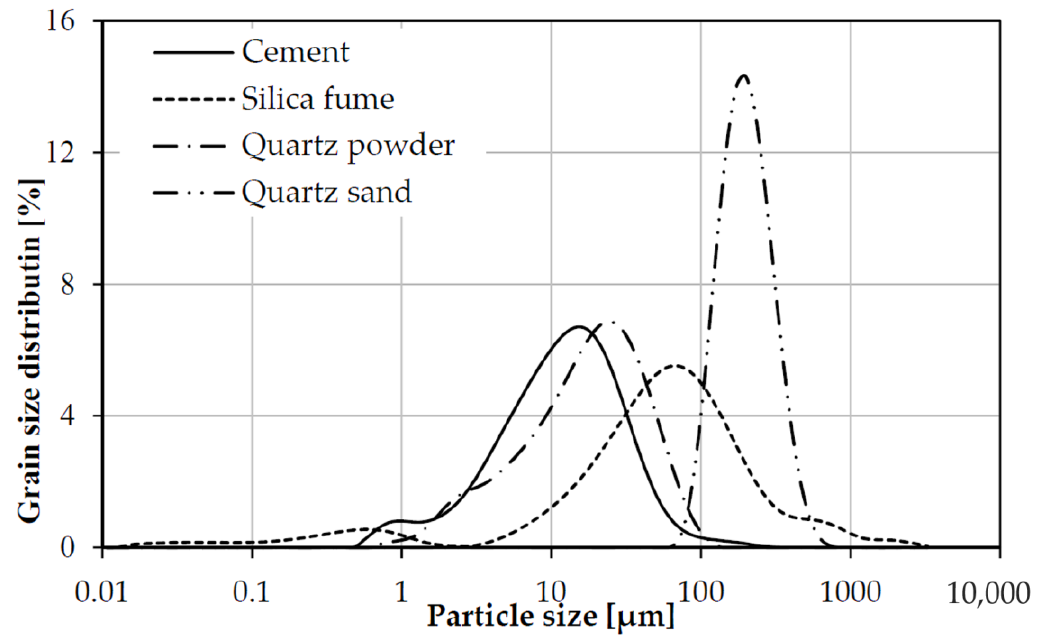
Figure 1. Grain composition of cement, silica fume, quartz powder, and quartz